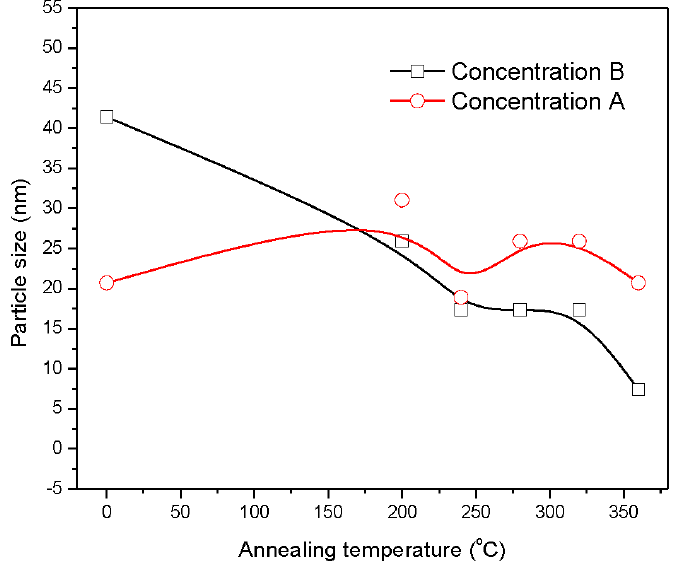
Figure 3. Variation of crystallite size with the annealing